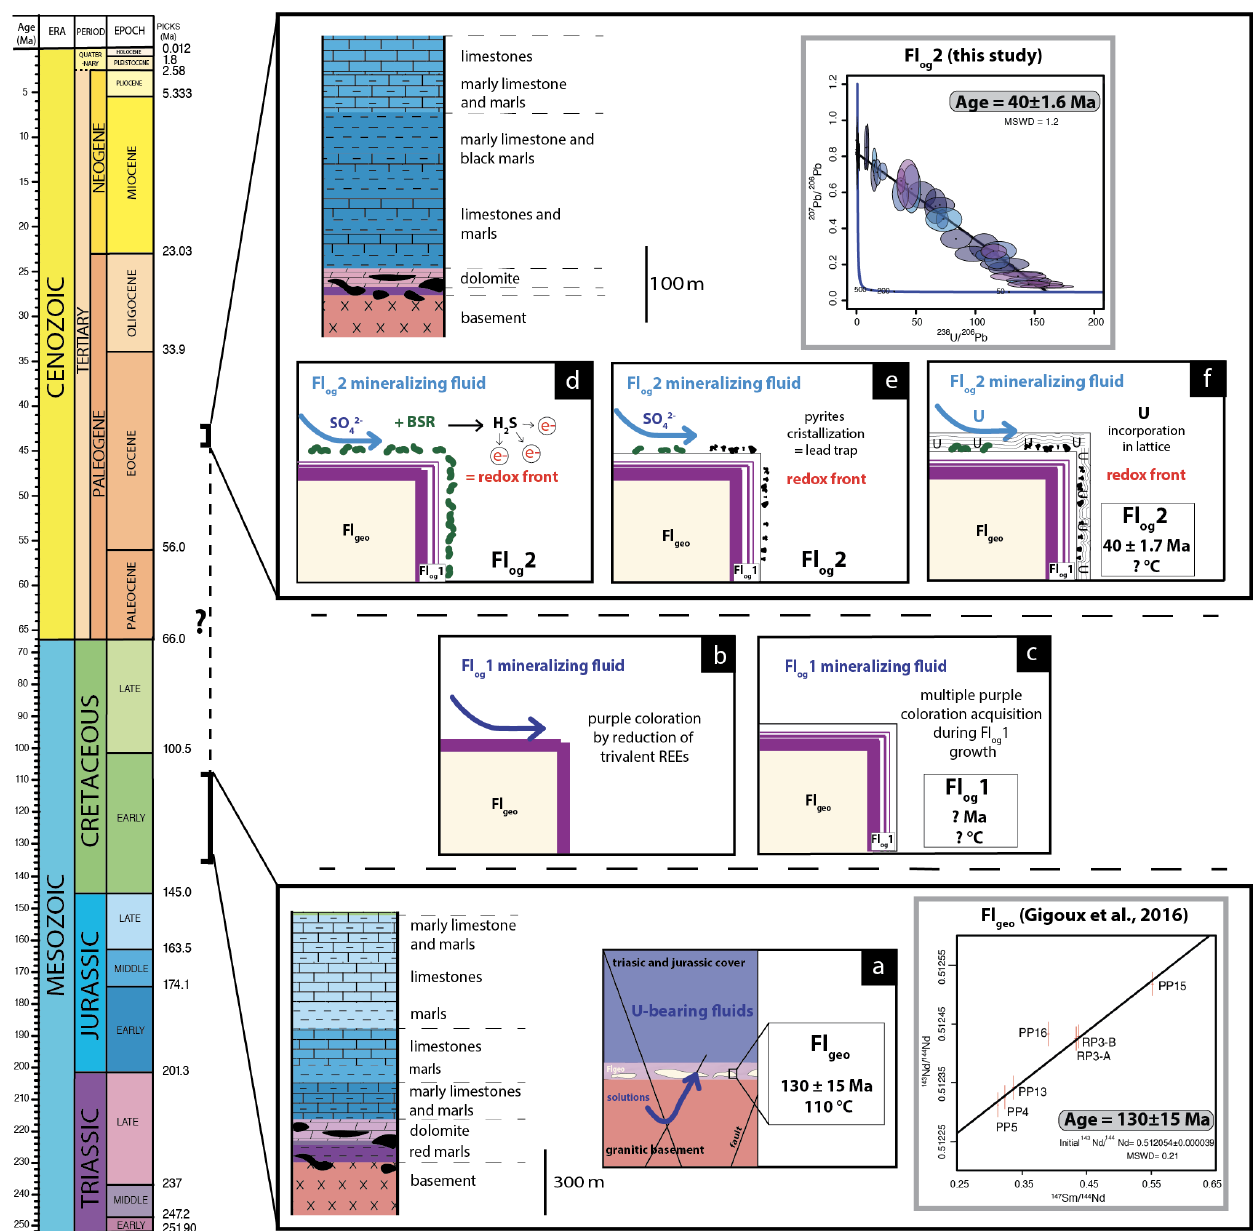
Figure 9. Conceptual model of U incorporation in the fluorite lattice. (a) Uranium is leached by F-rich solutions flowing through the granitic basement and reaching Fl geo in the basement–cover interface. (b) Formation of purple layers on the fluorite surface by F-bearing fluids. (c) Crystallization of Fl og 1. (d) A local redox front is generated by BSR. (e) S species react with Fe oxyhydroxides or dissolved Fe to form pyrite. (f) U is incorporated in Fl og